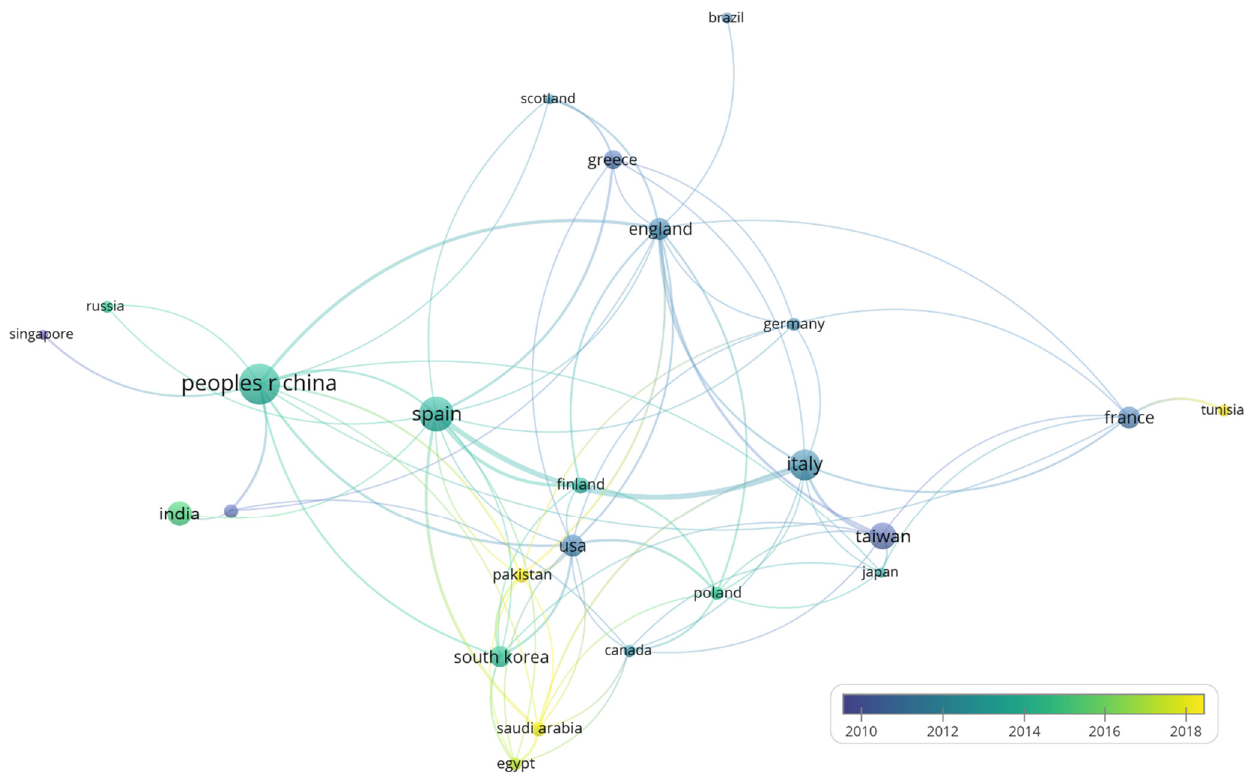
Figure 6. The country map on the ontology- and fuzzy-based IS topic generated from WoS.